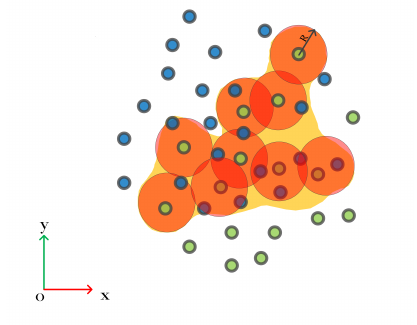
Figure 5: Point based intersection area determination.